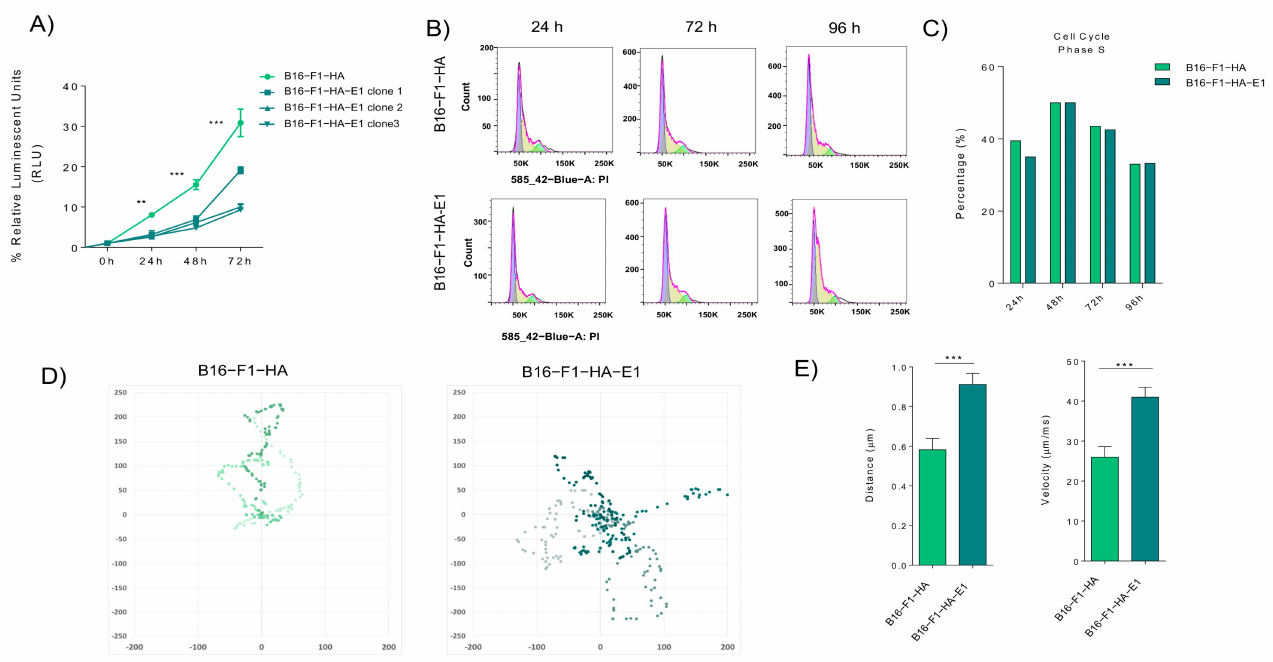
Figure 3. EMILIN-1 overexpression reduces cell viability and directionality cell migration. ( A ) Analysis of cell viability using CellTiter-Glo ® Luminescent Cell Viability Assay after EMILIN-1 expression of B16-F1-HA and different clones of B16-F1-HA cells overexpressing EMILIN-1 at indicated time point ( n = 2) ** p < 0.01 and *** p < 0.001 by 2- way ANOVA. Relative Luminescent Units (RLU) are represented in y axis. ( B ) Representative histograms showing the cell cycle distribution in B16-F1-HA and B16-F1- HA-E1 models at 24, 72 and 96 h. ( C ) Relative changes in the percentage of B16-F1-HA and B16-F1-HA-E1 cells in S phase after addition of Edu. ( D ) Representative examples of cell tracking and motility analysis in B16-F1-HA and B16-F1-HA-E1 models. ( E ) Distance and velocity of cell tracking analysis by ImageJ software *** p < 0.001 by Unpaired t